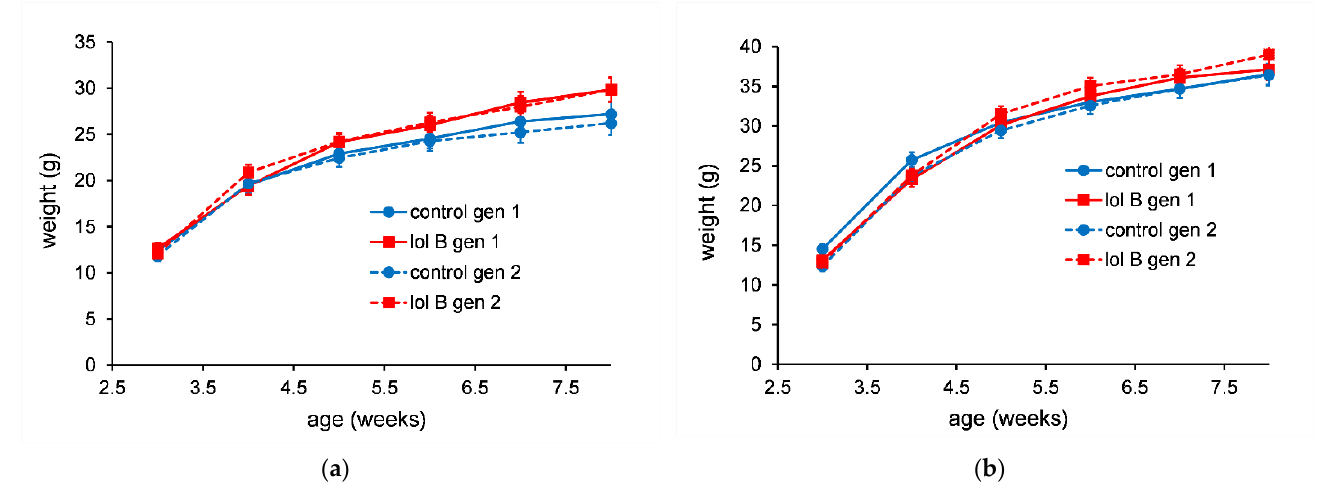
Figure 5. The average weight of individual female mice ( a ) or male mice ( b ) ( n = 5) fed diet containing lolitrem B (1.06 ppm). The error bars are the standard error obtained from the fitted model.